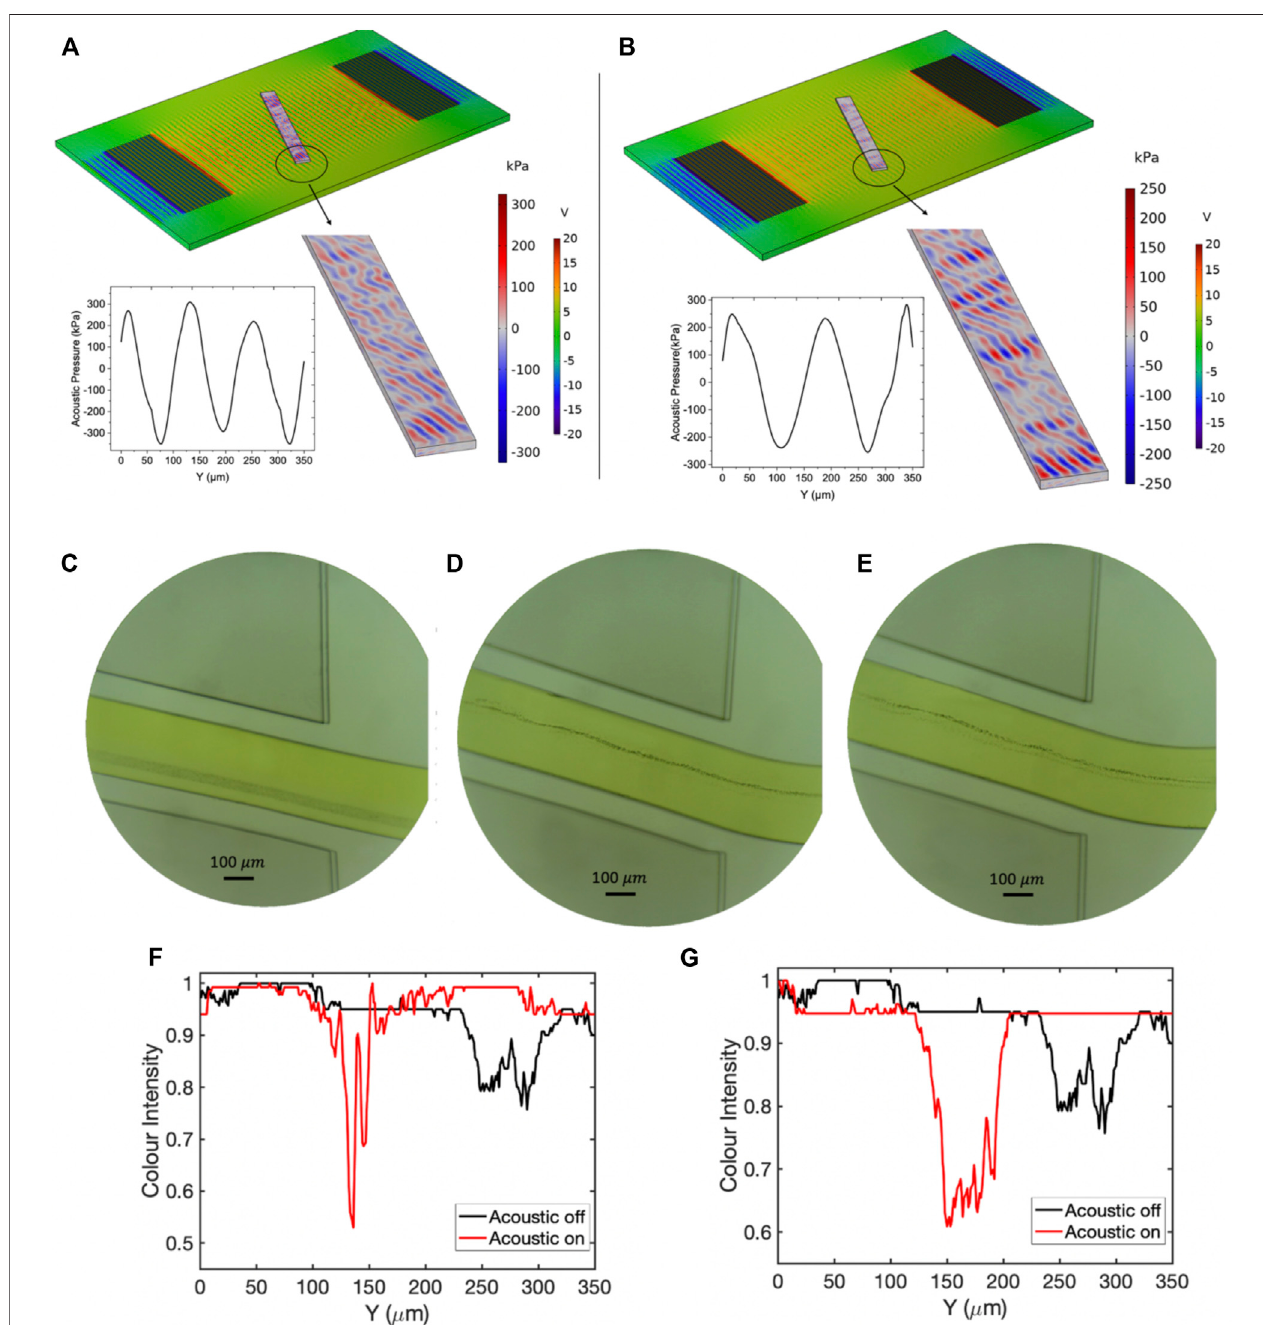
FIGURE 13 | The results of pressure distribution and experimental tests for experiment number 12 with Q-factor 14 in resonant frequency and 0 . 5 MHz deviation from resonant frequency. (A) The distribution of pressure and voltage across the microchannel in resonant frequency. (B) The distribution of pressure and voltage across the microchannel with 0 . 5 MHz deviations from resonant frequency. (C) Sheath fl ow focusing of the stream of 0 . 5 μ m particles before SSAW excitation. (D) Microbead focusing fl owpathafterSSAWexcitationinresonantfrequency. (E) Particle fl owpathafterSSAWexcitationin0 . 5 MHz off-resonantfrequency. (F) Graphofcolourintensitybeforeand after acoustic actuation in resonant frequency (G) Graph of colour intensity before and after acoustic actuation in off-resonant frequency.